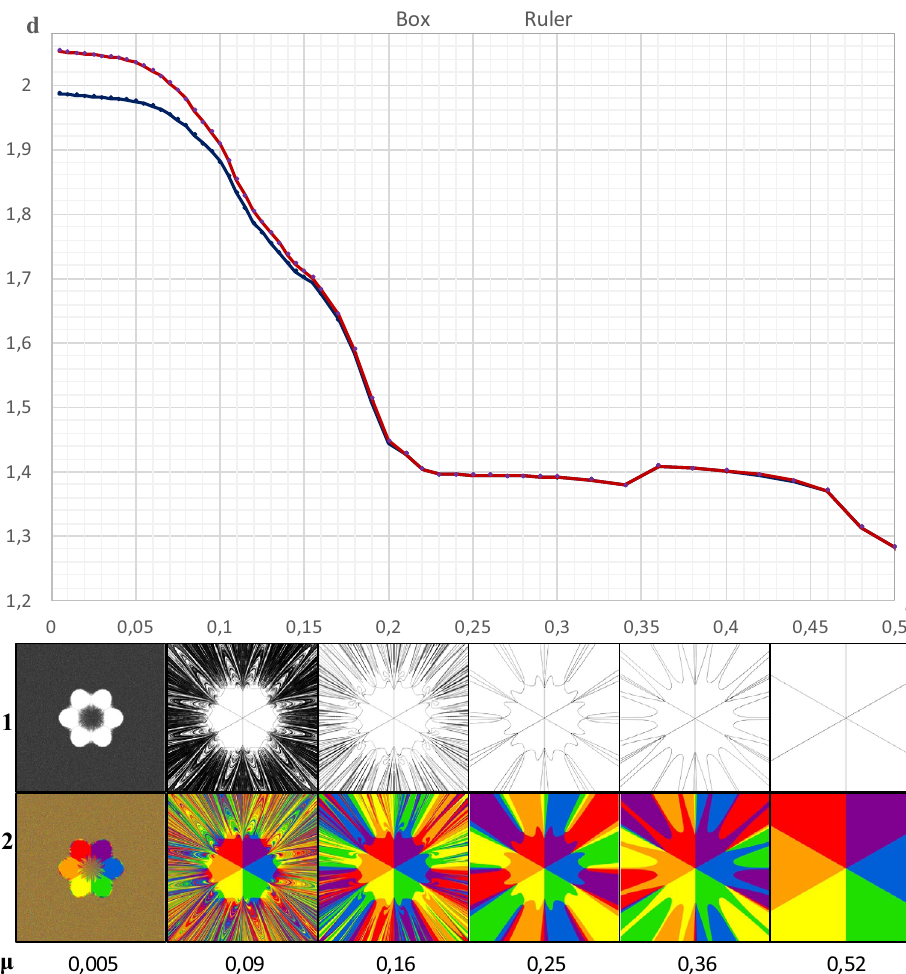
Figure 3. Comparison of the variability of the global ruler and box dimensions. Legend: The edge of all attraction basins is a function of the μ coefficient; 1–edges of all basins, 2–entire